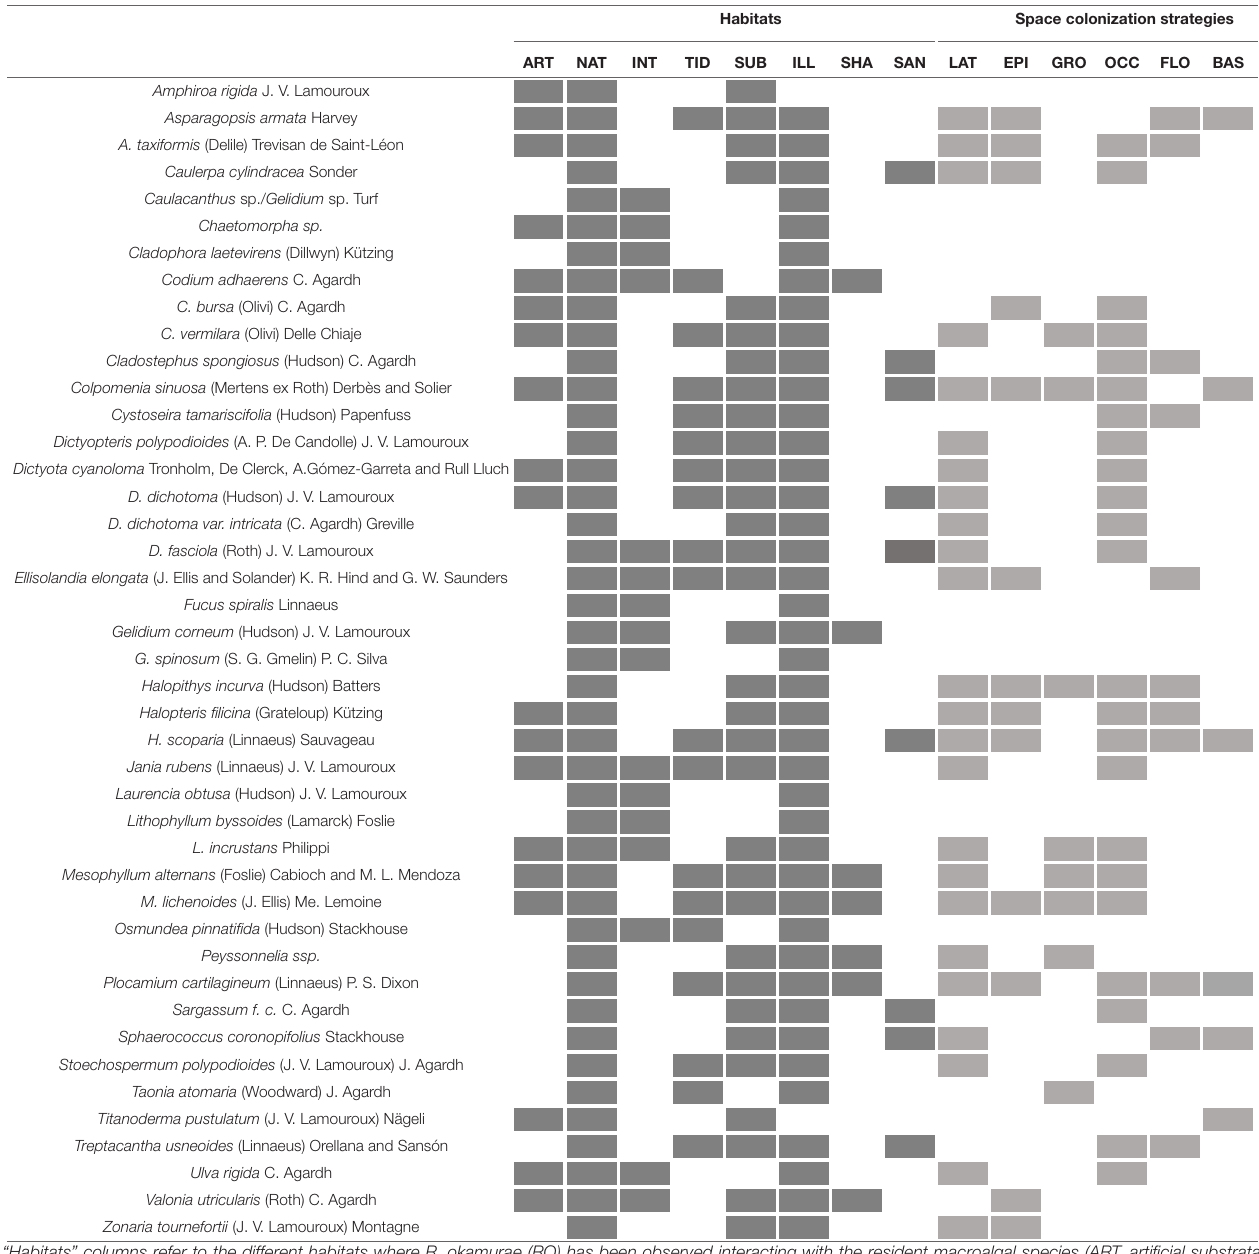
TABLE 2 | Presence (shaded quadrats) of perceived interactions between R. okamurae and resident macroalgal species at introduced habitats.